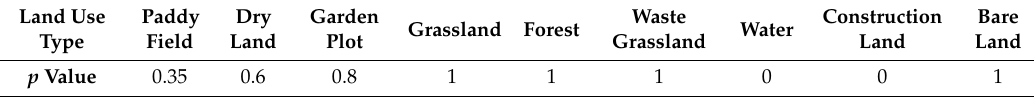
Table 2. p value of di ff erent land use types in